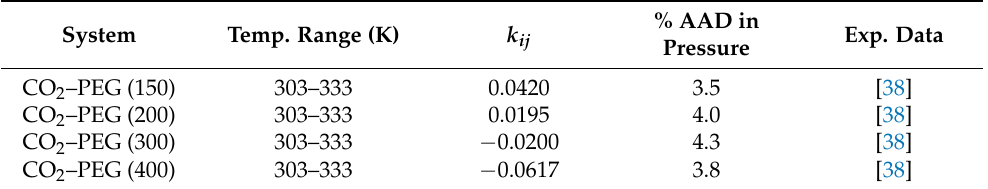
Table 3. Binary interaction parameters ( k ij ) and deviations from experimental data for CO 2 –polyethylene glycols (the average molecular weight is shown in parenthesis).